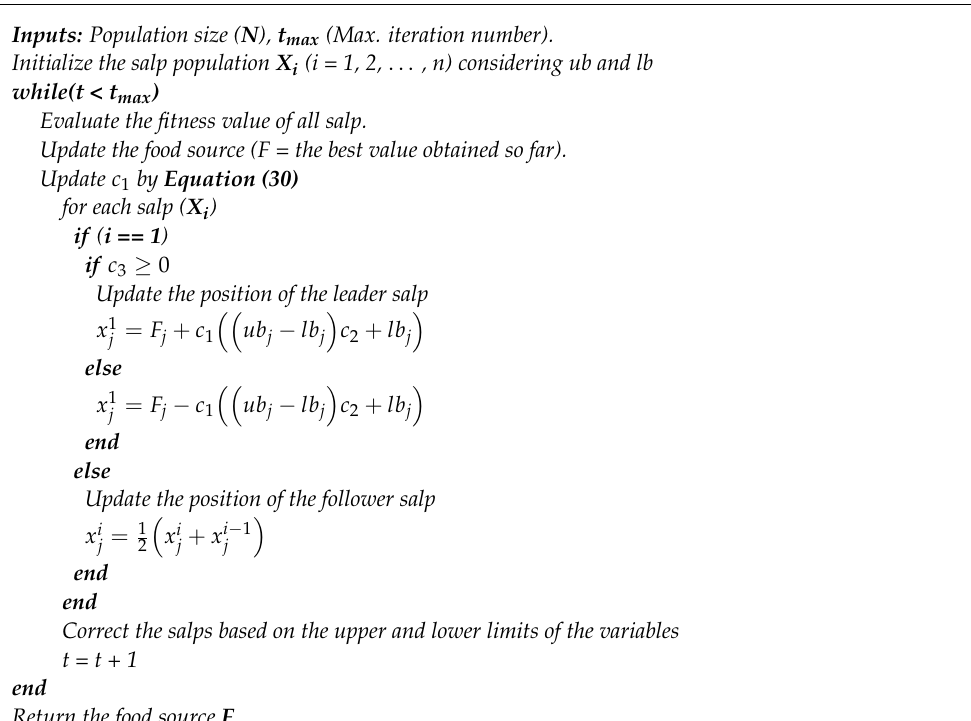
Algorithm 5 Pseudocode of Salp Swarm Algorithm